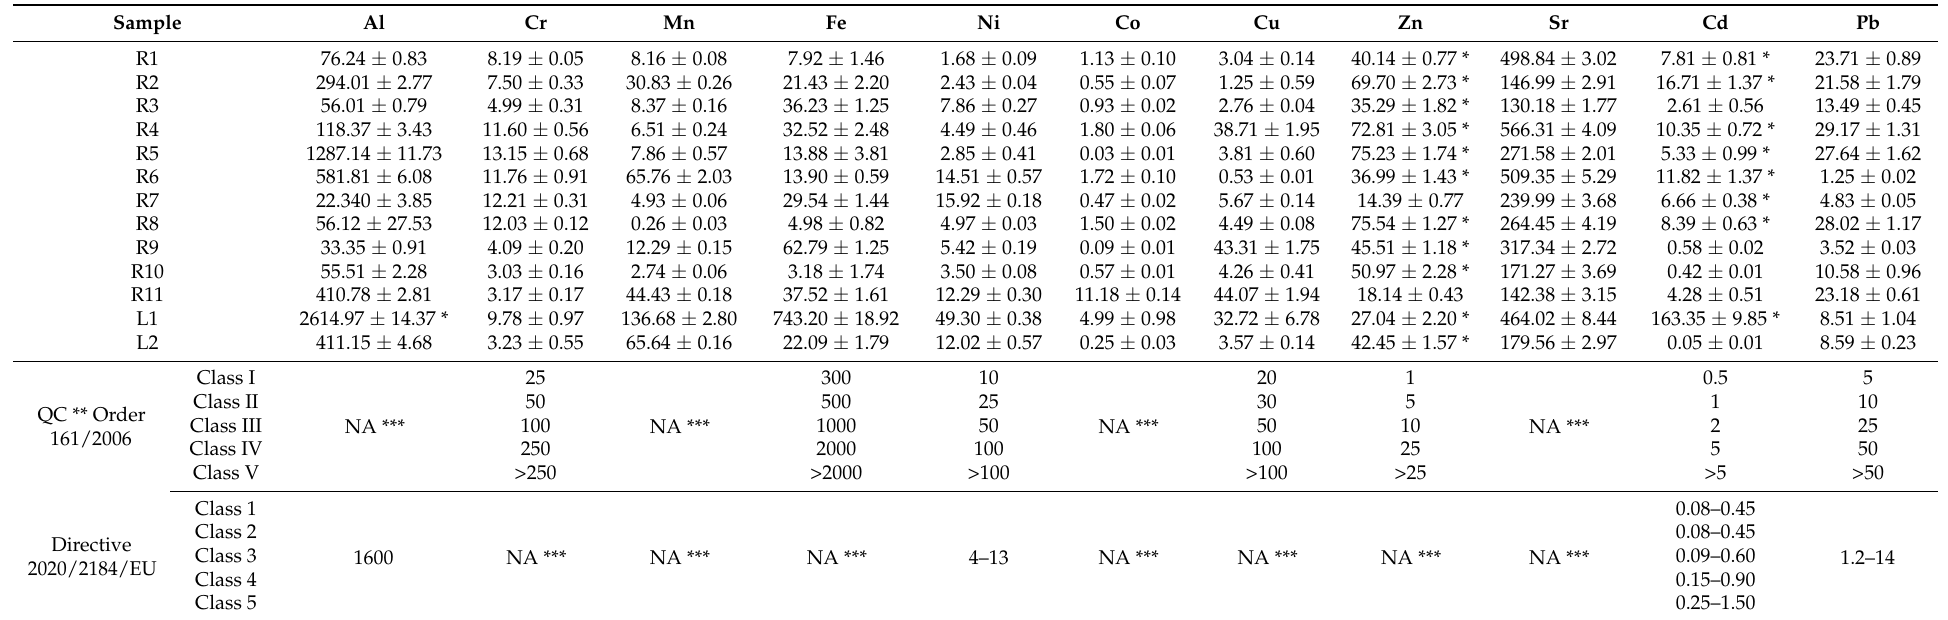
Table 6. Mean concentration of metals (expressed as µ g/L ± S.D.) in surface waters (river and lake) from the Banat mining area.